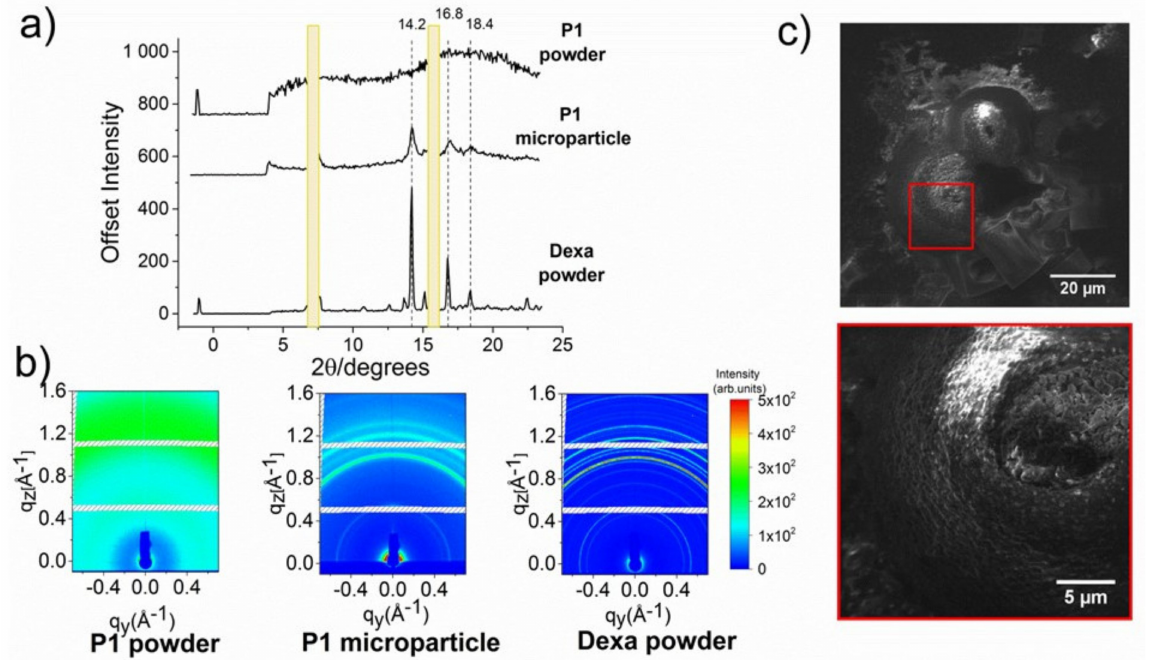
Figure 7. Characterization of dried microparticles from P1 copolymer (10 mg · mL − 1 ) and Dexa (2 mg · mL − 1 ), examined by WAXS (1D profiles of Dexa powder, polymer P1 powder, and microparticles in ( a ), reciprocal maps in ( b ), SEM images ( c ). Dexa and copolymer P1 were measured separately in solid-state using WAXS